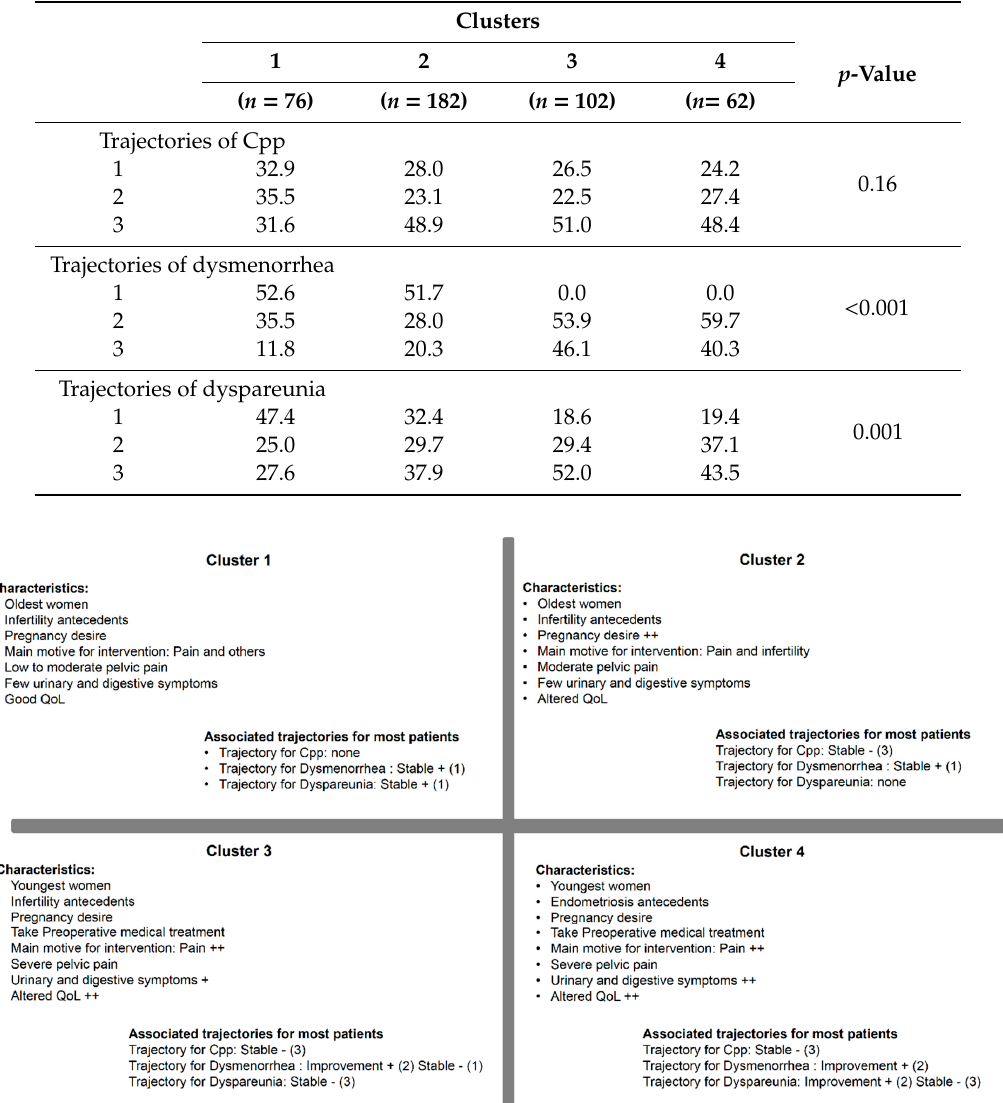
Table 4. Crossing of the different trajectories with Clusters. Cpp: chronic pelvic pain.